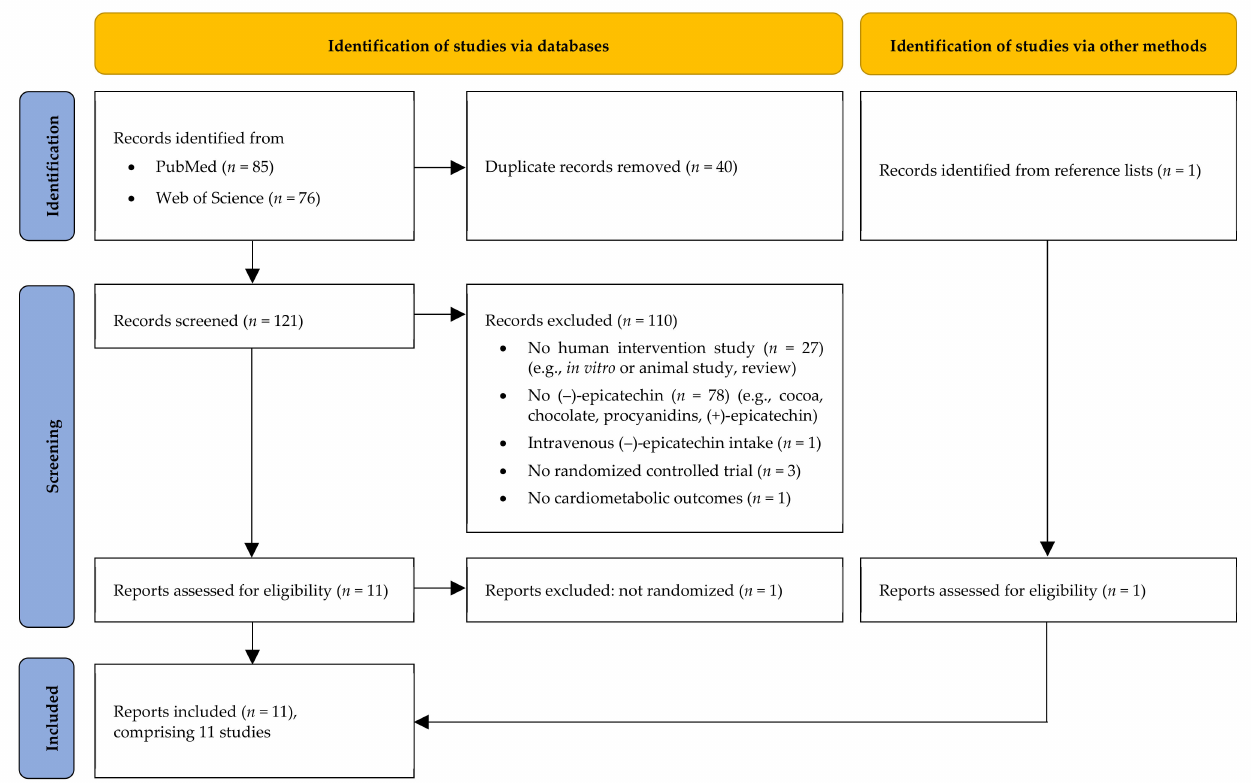
Figure 1. Flow diagram of study selection process modified according to the Preferred Reporting Items for Systematic Reviews and Meta-Analyses (PRISMA) 2020 statement